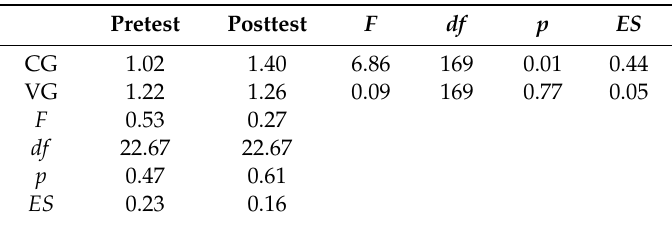
Table 5. Number of fixations per shot (mean), F -values, degrees of freedom (df ), p -values, and e ff ect size (ES) for pairwise comparisons of CG and VG in pre- and posttests. Pretest Posttest